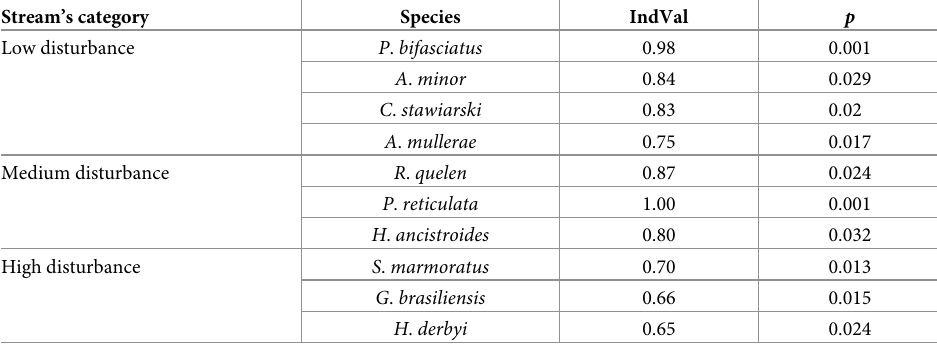
Table 3. Species indicators defined by IndVal analysis, performed for each stream according to the IDI